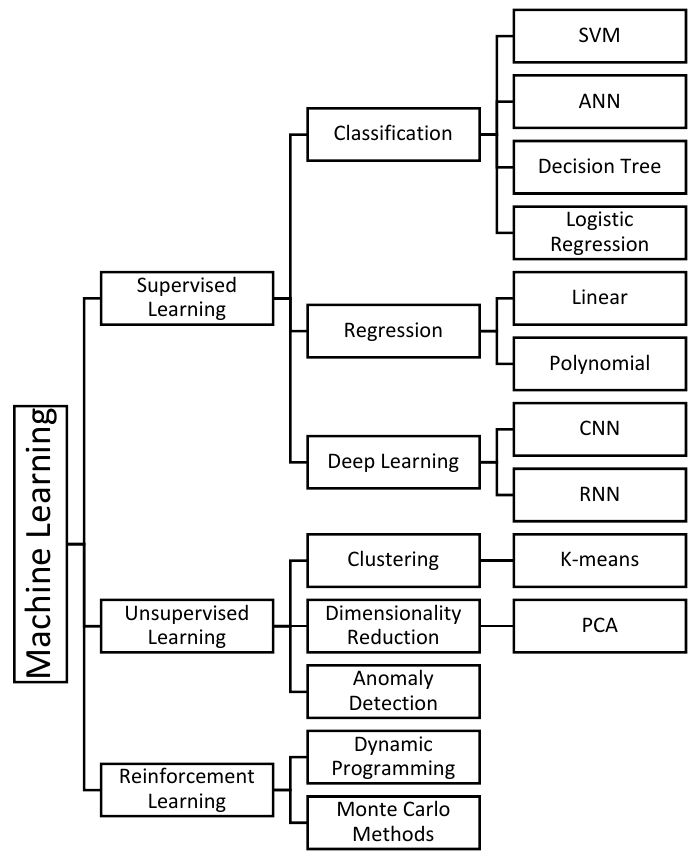
Figure 13. Schematic of machine learning algorithms.